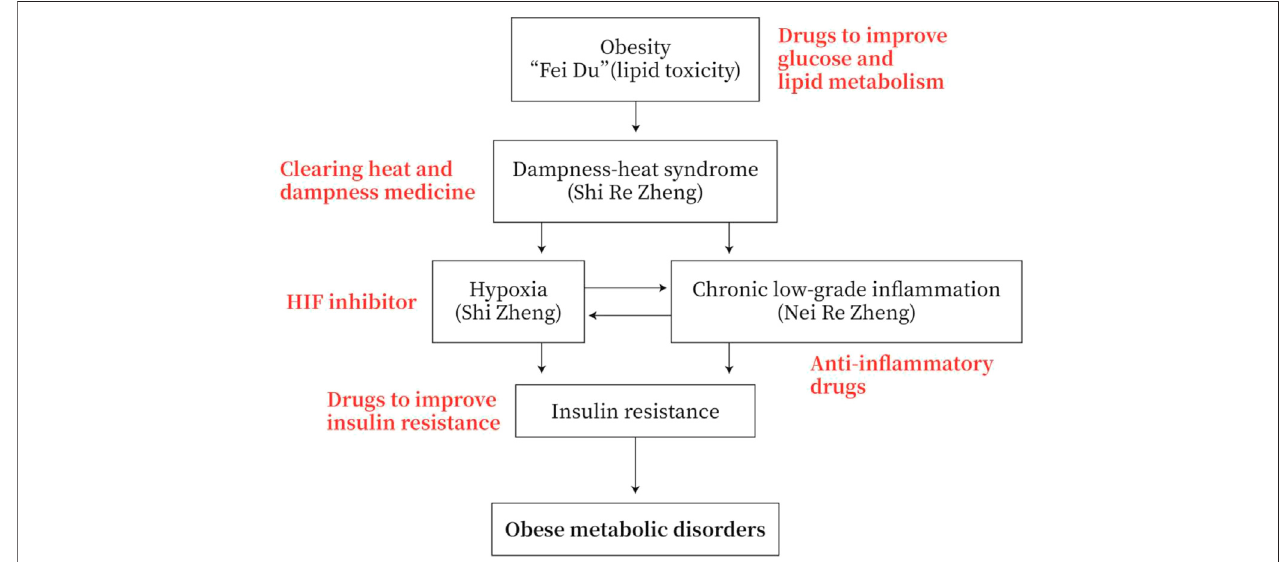
FIGURE 4 | Strategies for the prevention and treatment of obese metabolic disorders. Obesity has the symptoms of “ dampness heat ” . Obesity patients exhibit dysfunction of glucose and lipid metabolism. They generally have adipose tissue and/or small intestine hypoxia and chronic low-grade in fl ammation, and they are prone toinsulinresistance(IR)andobesemetabolicdiseases.Therefore,theTCMdrugstopreventandtreatobesity-typemetabolicdiseasesaremainlyheat-clearingandanti- dampness, or in MWM anti-in fl ammation, inhibiting HIF and improving IR.